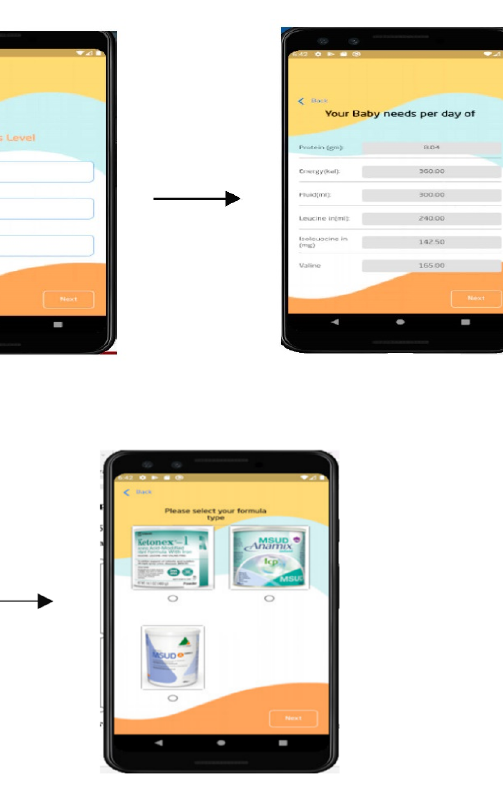
Figure 4. Allowing the caregivers to choose their preferred medical/commercial formulas.